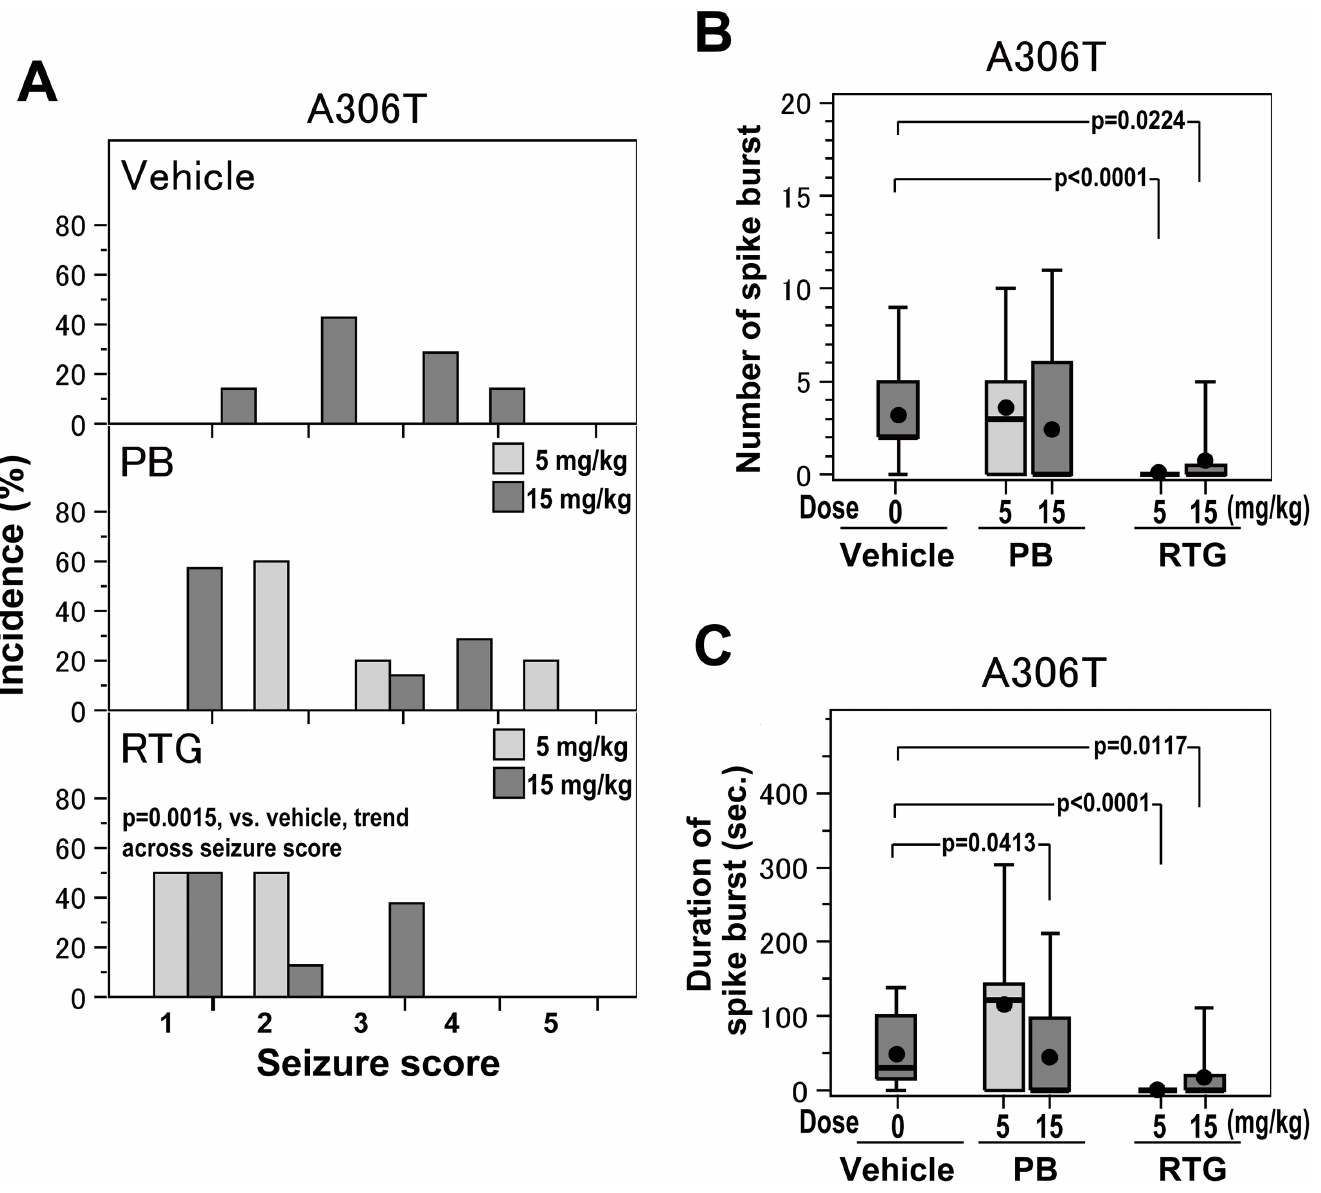
Fig 5. The effects of phenobarbital (PB) and retigabine (RTG) at low and high doses on seizure in Kcnq2 A306T/+ mice. A. Distribution of seizure scores in Kcnq2 A306T/+ mice administered vehicle (n = 7) (upper panel, in gray color), PB at doses of 5 mg/kg (n = 5) and 15 mg/kg (n = 7) (middle panel, in light gray and gray color, respectively), or RTG at doses of 5 mg/kg (n = 6) and 15 mg/kg (n = 8) (lower panel, in light gray and gray color, respectively). Between and within drug differences in the distribution of seizure scores were examined by the Jonckheere − Terpstra test, as described in the Methods. B and C. Box-and- whisker plots showing the mean ( ● ), median (middle bar in the rectangle), and 10 th (bottom bar), 25 th (bottom of rectangle), 75 th (top of rectangle), and 90 th (top bar) percentiles of the number (B) and duration (C) of spike bursts in Kcnq2 A306T/+ mice administered vehicle (n = 7), PB at doses of 5 mg/kg (n = 5) and 15 mg/kg (n = 6), or RTG at doses of 5 mg/kg (n = 6) and 15 mg/kg (n = 8). PB and RTG at doses of 5 mg/kg are shown in light gray color. Between and within drug differences in terms of the number and duration of spike bursts were examined using Negative binomial model, as described in the Methods. Raw data for bar and box plots are included in S1